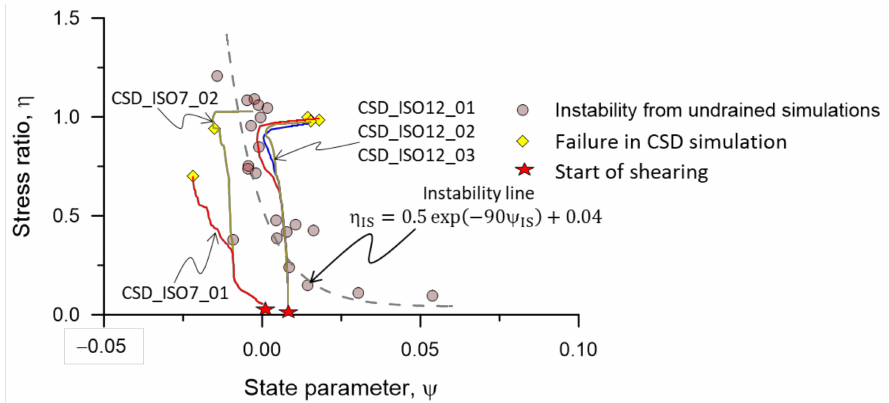
Figure 10. The evolution towards the instability line in the η – ψ